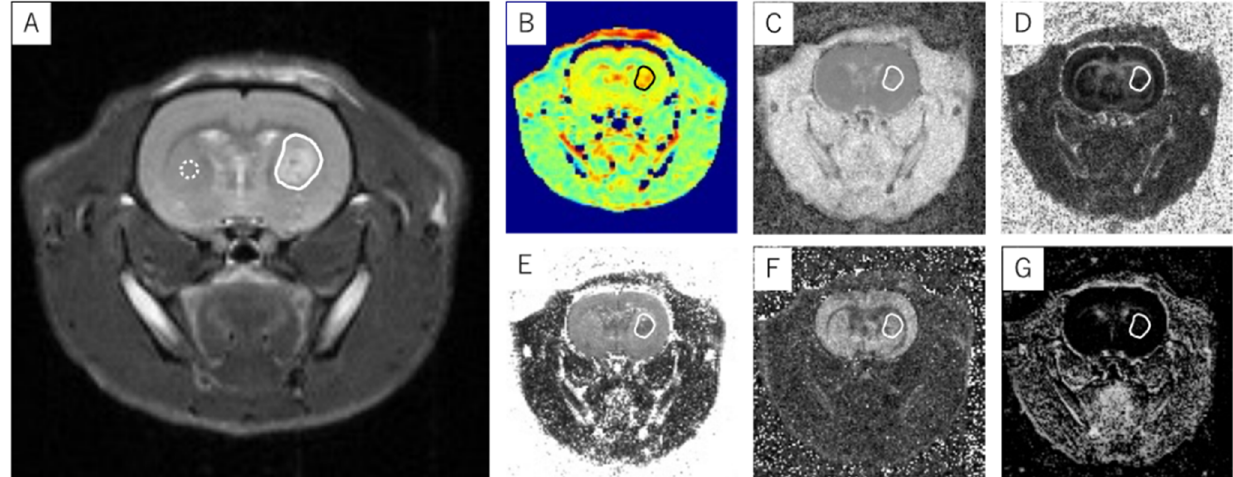
Figure 2. An example of ROI placement in a glioblastoma model. An ROI that covered the entire tumor was placed at the T 2 WI slice position ( A ) where the brain tumor was most widely observed. The ROI was replicated in APT imaging ( B ) and ADC ( C ), FA ( D ), ICVF ( E ), ODI ( F ), and ISO maps ( G ) at the same slice position as the T 2 WI, and each measurement was performed. The T 2 signal intensity ratio was calculated as the ratio of the average signal value in the solid line ROI to the average signal value in the dotted line ROI. Solid line ROI: transplanted tumor; dotted line ROI: contralateral normal brain